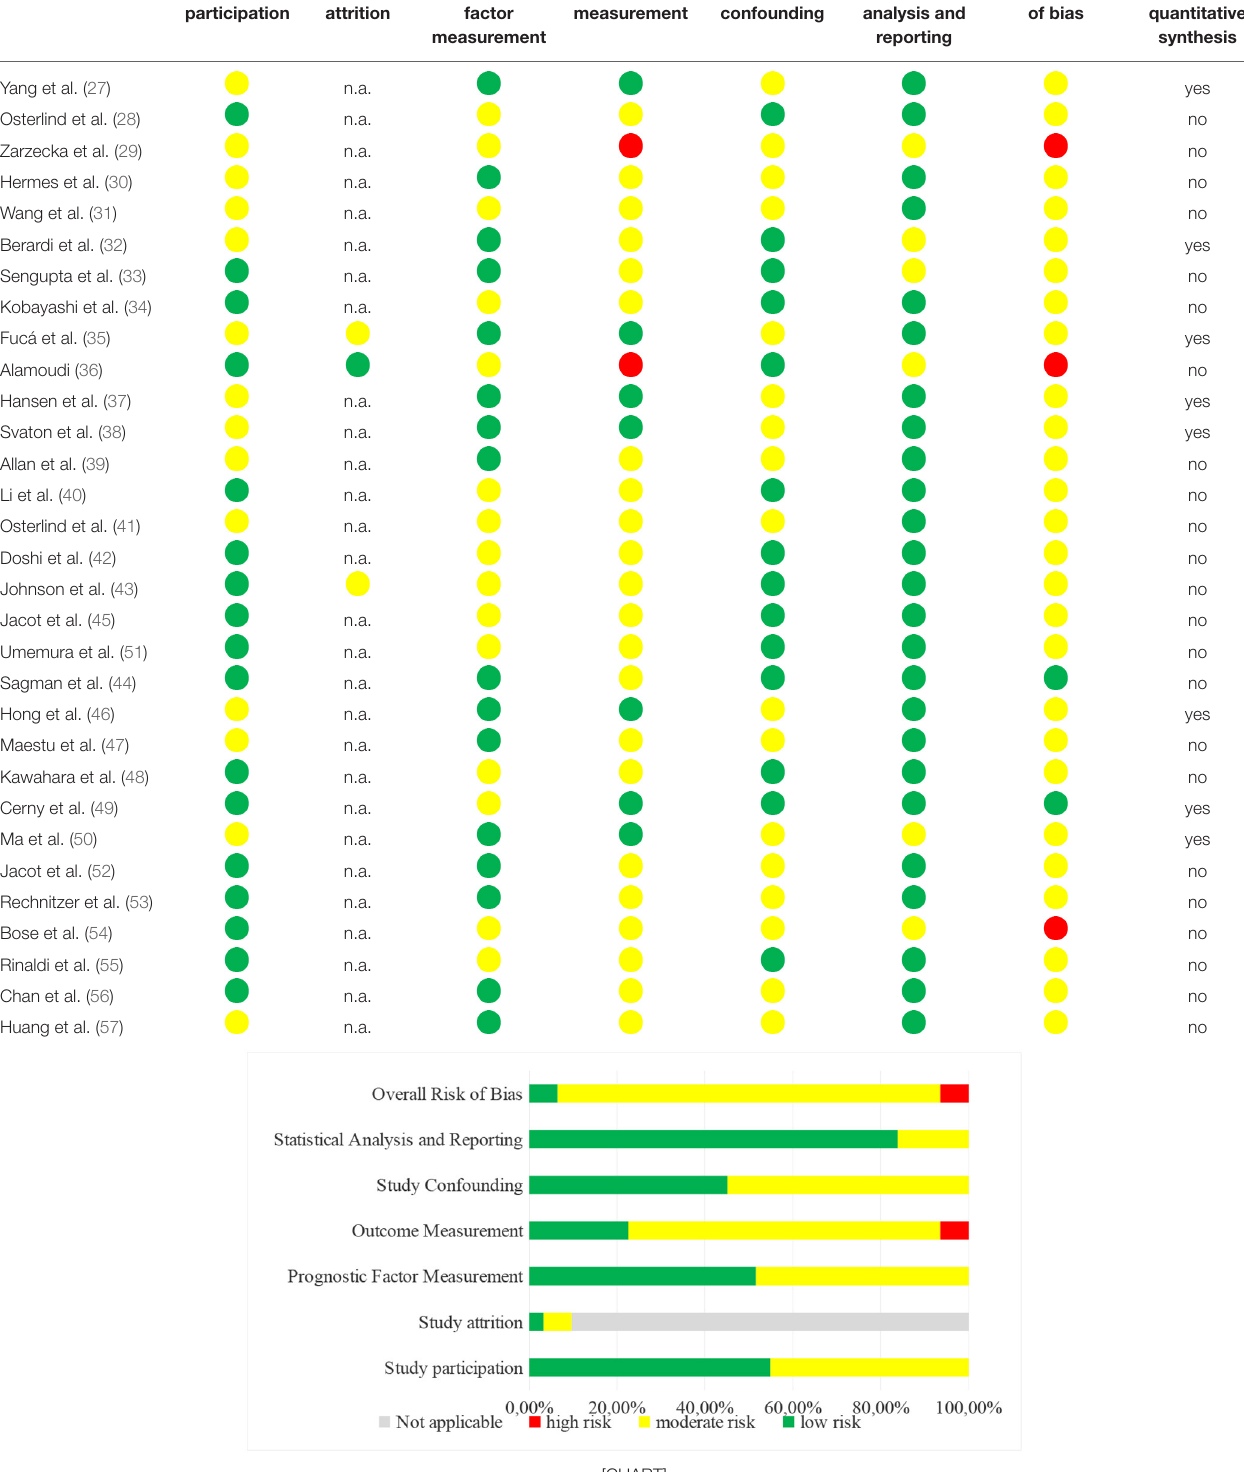
Study participation